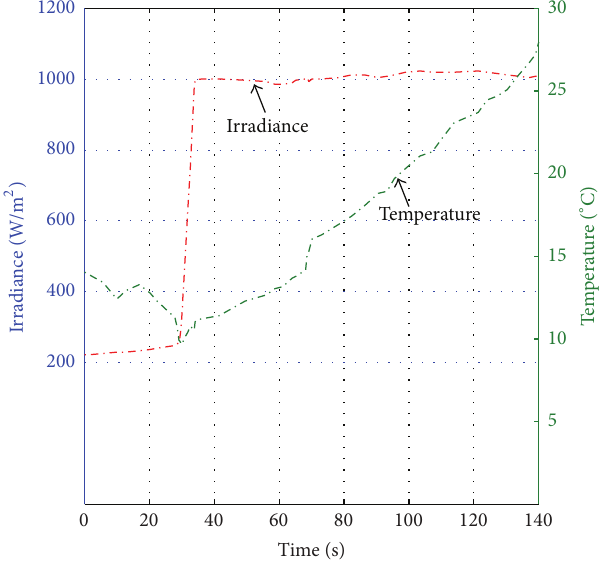
Figure 9: Depict a sequence of a rapid irradiation and temperature variation [11].